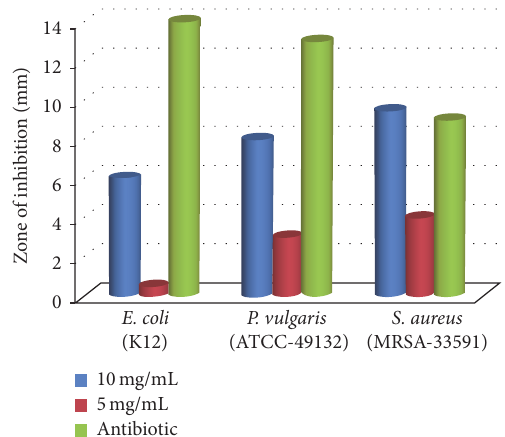
Figure 8: Representing zone of inhibition of ZnO nanoparticles tested on various bacterial species (E. coli-K12, P. vulgaris-ATCC- 49132, and S. aureus-MRSA-33591)